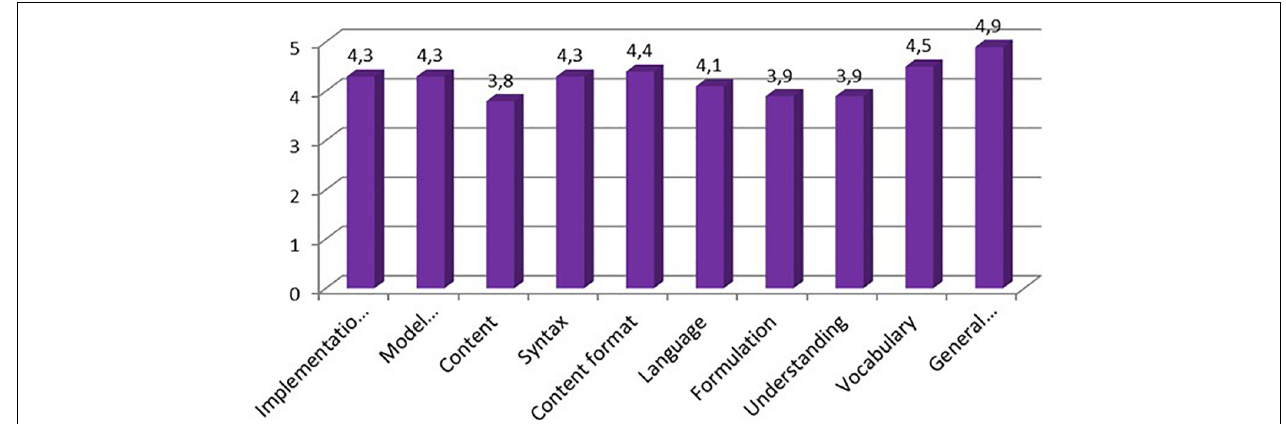
FIGURE 3 | Validation of the WBL-based industrial apprenticeship learning guide model for pre-service vocational teachers.